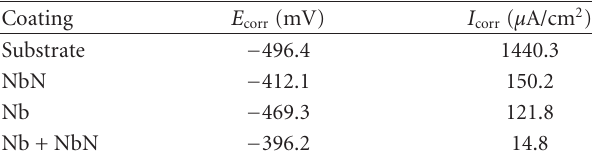
Figure 11: E OCP versus time for NbN/MS with and without Nb interlayer in 1N H 2 SO 4 . Table 6: E corr and I corr values for single and duplex coatings on